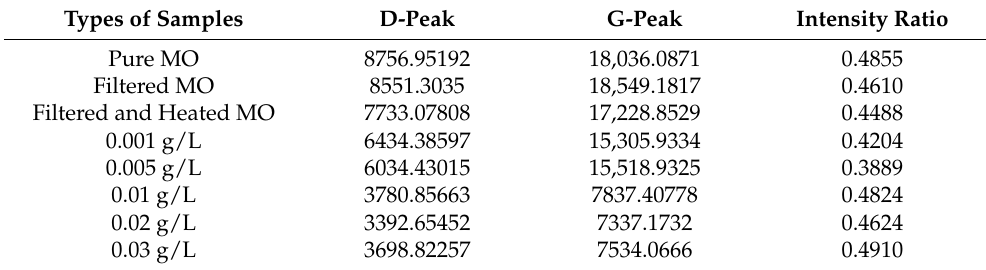
Table 7. Intensity ratio of D ‐ peak to G ‐ peak of different types of samples.